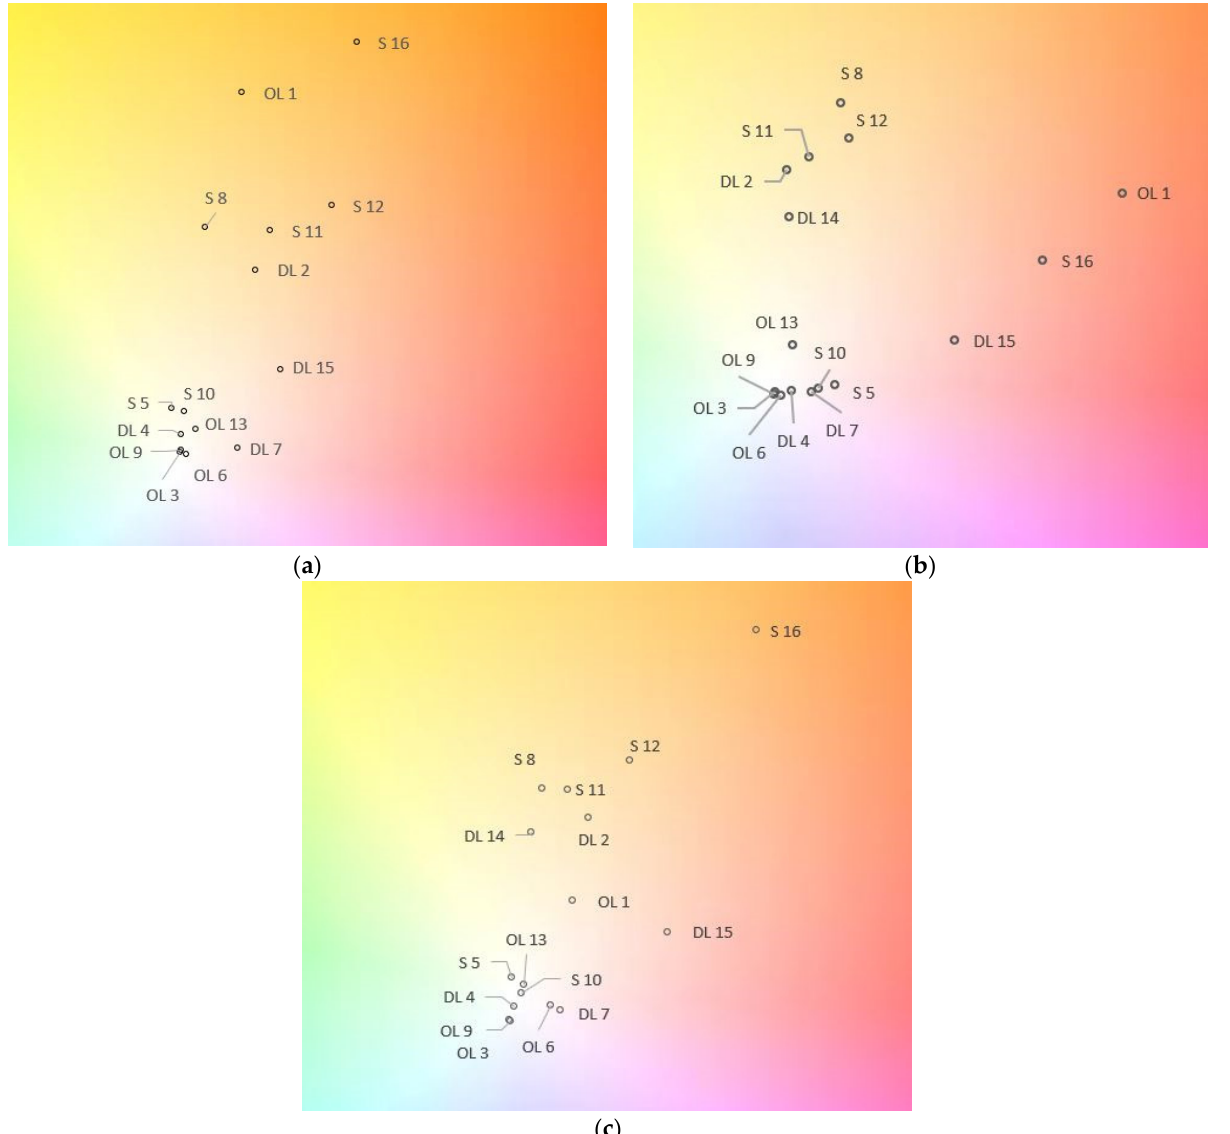
Figure 6. Representation of a* and b* coordinates in the color space CIEL*a*b for a color spot in different prints. Measuring spots: ( a ) amber 2; ( b ) red 3; ( c ) background 2. The average values of luminosity (L), chroma (C) and hue (h) and their uncertainties as standard deviation were calculated for all the amber, red and background spots. The results are shown in Tables 10–12. Information on the color of the paper, whether the film is positive or negative and an identifier of the ink is added to the table for an easier interpretation of the results. Table 10. Average luminosity, chroma and hue of all amber spots. Ordered according to the higher luminosity value.